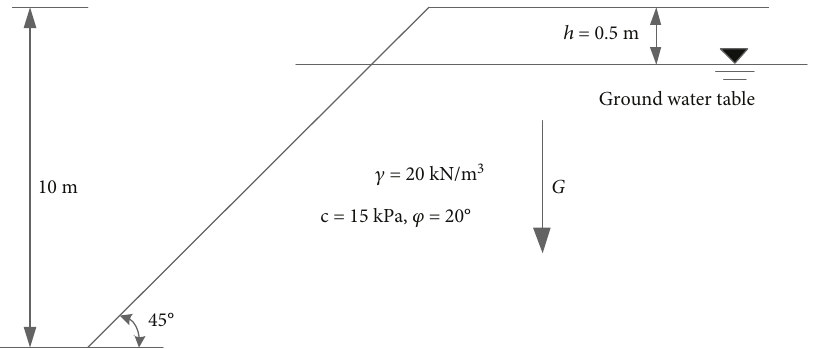
Figure 10: Parameters of a calculation model.